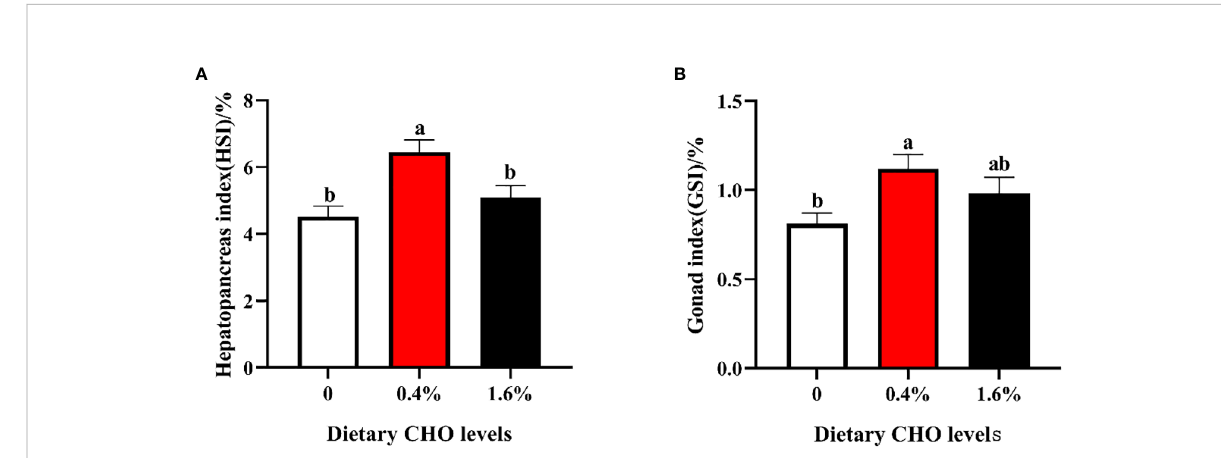
FIGURE 1 Effects of dietary CHO on (A) hepatopancreas index (HSI); (B) gonad index (GSI). The values are the Means ± SEM (n = 4). Different letters indicate signi fi cant differences ( P <